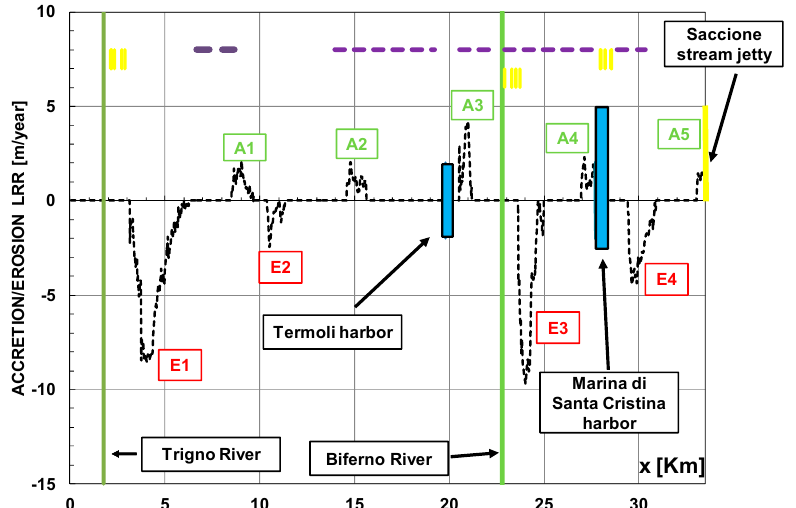
Figure 7. Erosion / accretion areas LRR function during the period 2004–2016. Horizontal dashes indicate Figure 7. Erosion/accretion areas LRR function during the period 2004–2016. Horizontal dashes the detached breakwaters; the vertical dashes indicate groin fields. indicate the detached breakwaters; the vertical dashes indicate groin fields.